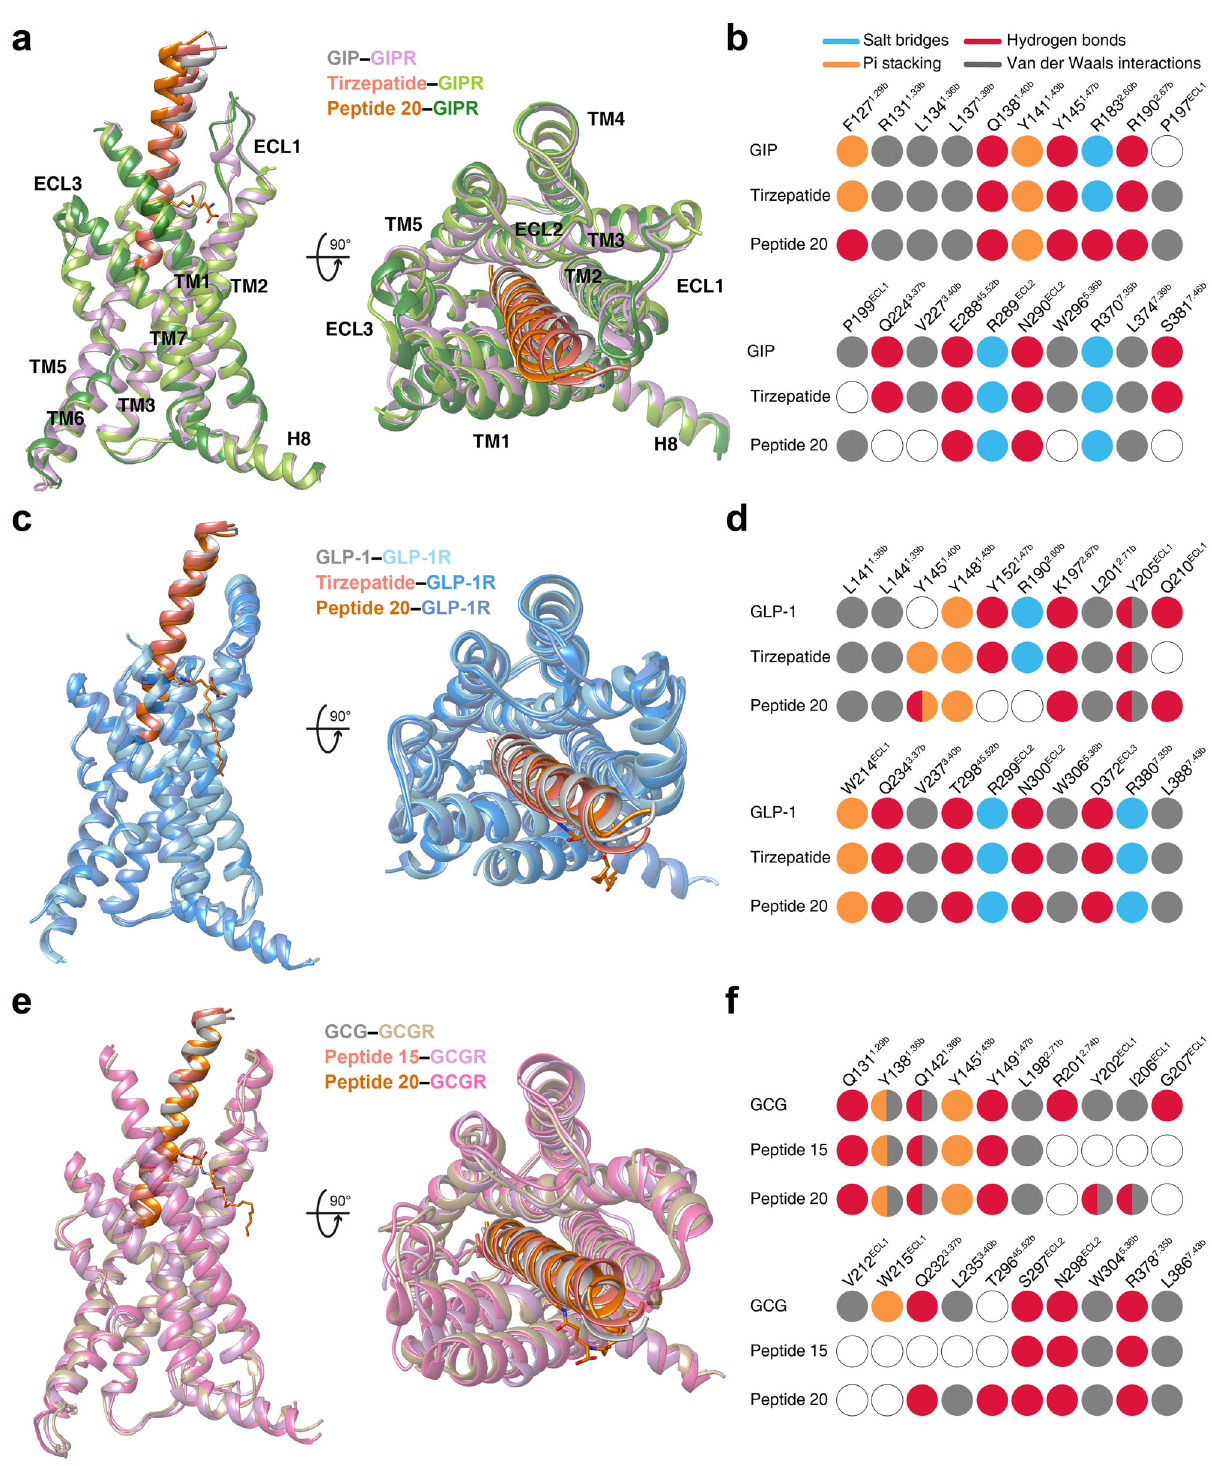
Fig. 2 Structural comparison of GIPR, GLP-1R and GCGR bound by mono-, dual and triple agonists. a Structural comparison of GIP – GIPR – G s 25 , tirzepatide – GIPR – G s and peptide 20 – GIPR – G s . Receptor ECD and G protein are omitted for clarity. b Comparison of residue interactions employed by GIPR to recognize GIP, tirzepatide and peptide 20, described by fi ngerprint strings encoding different interaction types of the surrounding residues in each peptide. Color codes are listed on the top panel. Residues that show no interaction with ligands are displayed as white circles. c Structural comparison of GLP-1 – GLP-1R – G s 27 , tirzepatide – GLP-1R – G s and peptide 20 – GLP-1R – G s . Receptor ECD and G protein are omitted for clarity. d Comparison of residue interactions that GLP-1R employed to recognize GLP-1, tirzepatide and peptide 20, described by fi ngerprint strings encoding different interaction types of the surrounding residues in each peptide. e Structural comparison of GCG – GCGR – G s 4 , peptide 15 – GCGR – G s 28 and peptide 20 – GCGR – G s . Receptor ECD and G protein are omitted for clarity. f Comparison of residue interactions that GCGR employed to recognize GCG, peptide 15 and peptide 20, described by fi ngerprint strings encoding different interaction types of the surrounding residues in each